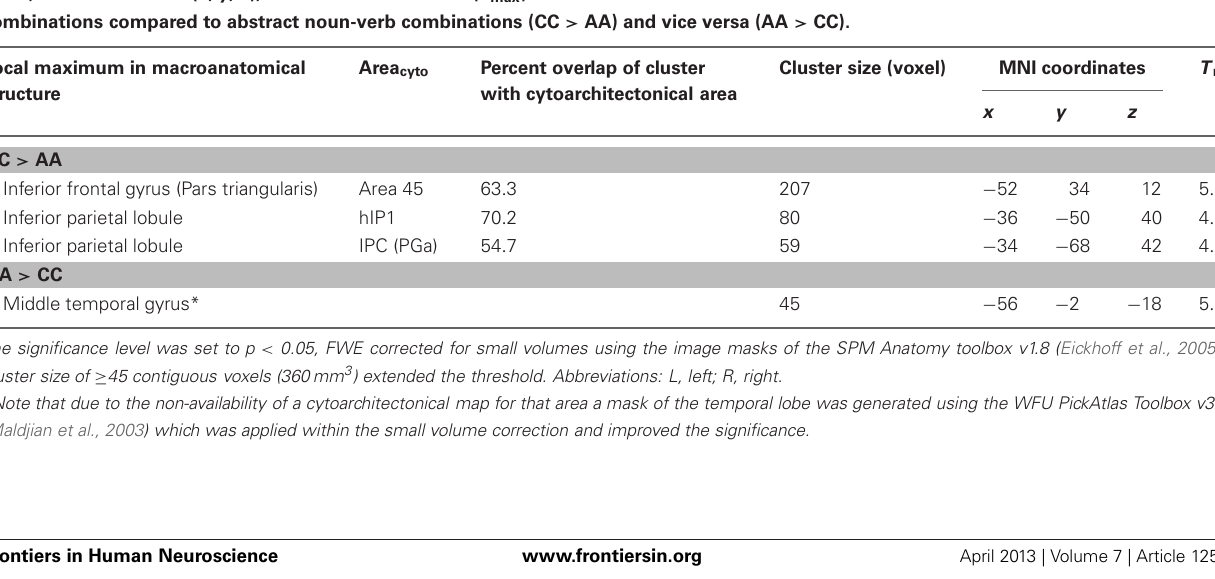
FIGURE 3 | Direct contrasts of concreteness vs. abstractness. Differences between processing concrete noun-verb combinations (top panel) compared to abstract noun-verb combinations (bottom panel) and extracted contrast values for the pure abstract, the summarized mixed conditions and the pure abstract condition from defined local maxima. Note that for visualization the statistical images were thresholded at p < 0 . 001, uncorrected, with an extended cluster size of ≥ 45 contiguous